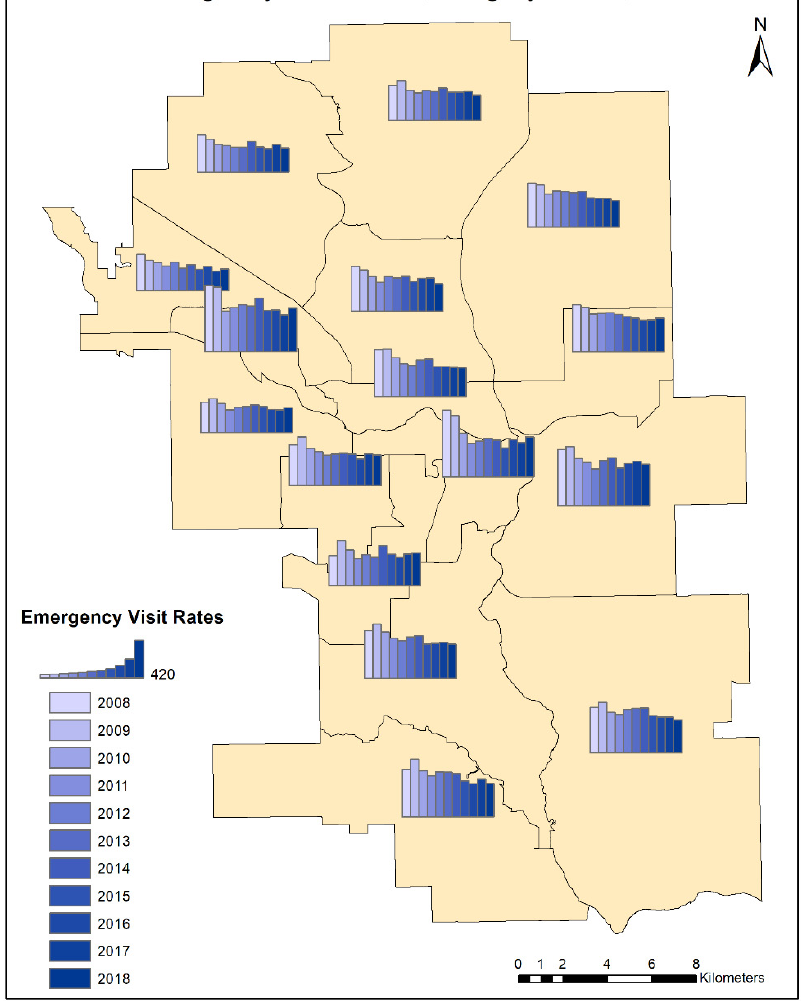
Figure 2. Histograms representing the yearly distribution (2008–2018) of Asthma Emergency Visit Rates (AEVR) for the Calgary LGAs (Local Geographic Areas).